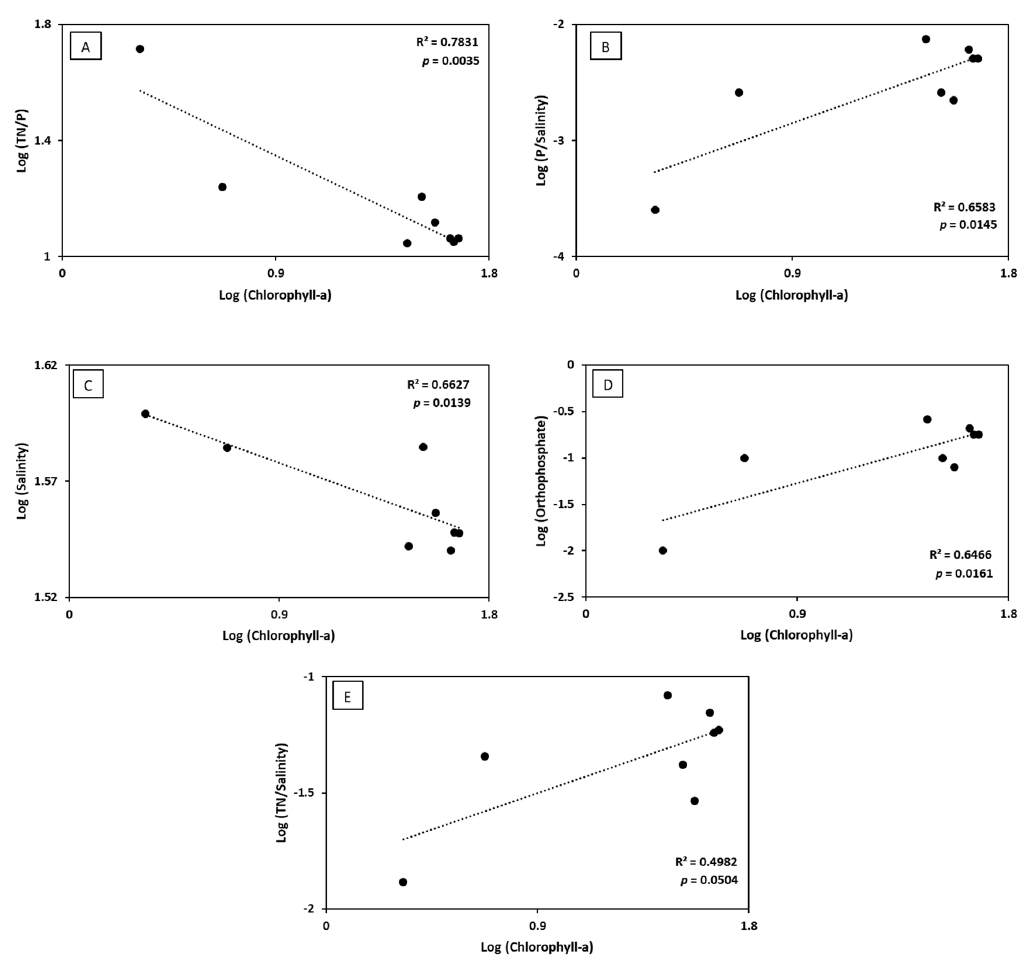
Figure 7. The relationship between the in-situ chlorophyll-a and the eutrophication indicators ( A ) TN / P, ( B ) P / Salinity, ( C ) Salinity, ( D ) Orthophosphates, ( E ) TN / salinity.